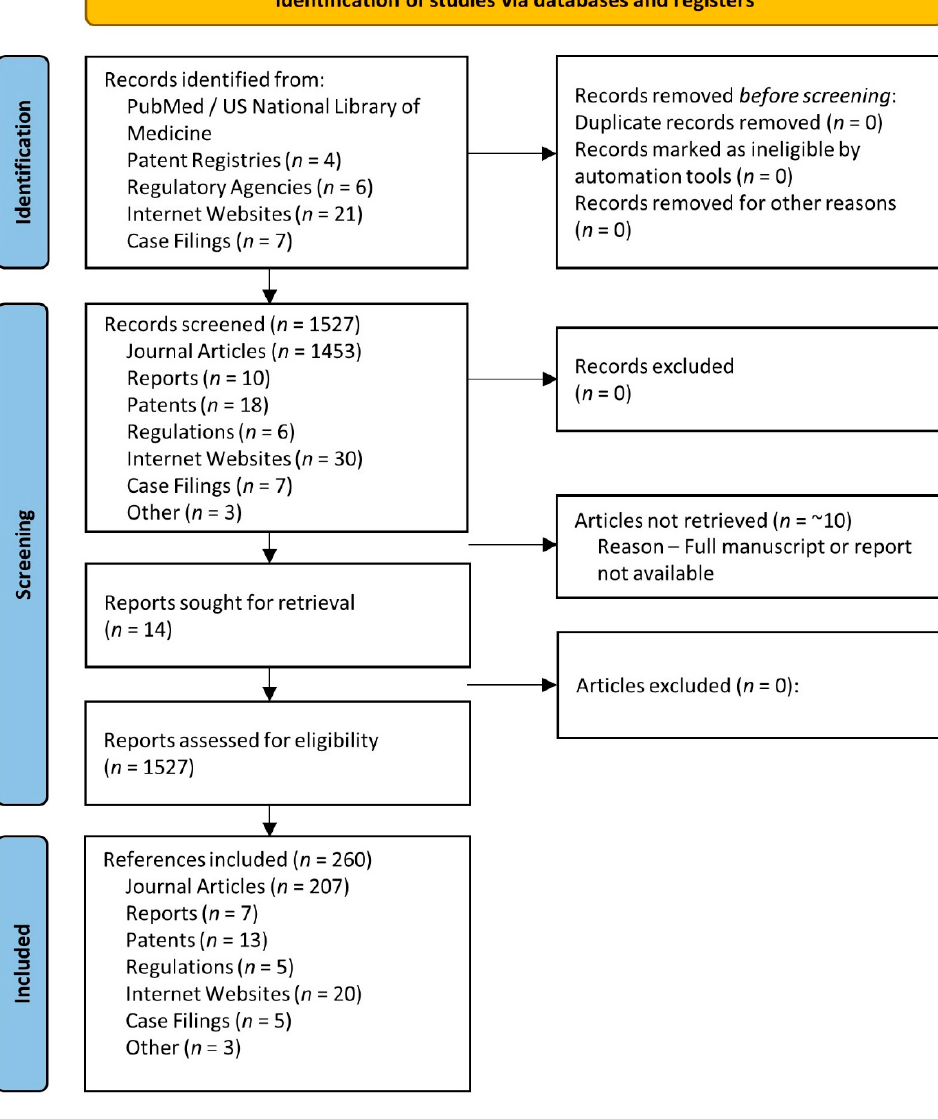
Figure 1. PRISMA flow chart.